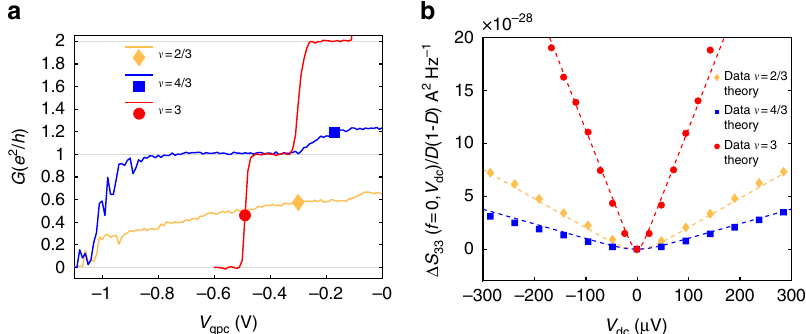
Fig. 2 Low frequency measurements. a Conductance through the QPC as a function of the QPC gate voltage for the three fi lling factors ν = 3 (red), ν = 4/3 (blue) and ν = 2/3 (yellow). The values of the QPC gate voltage used for noise measurements are shown by a colored disk ( ν = 3), square ( ν = 4/3) and diamond ( ν = 2/3). b Measurements of Δ S 33 ( f = 0, V dc ) normalized by the factor D (1 − D ). Dashed lines represent plots of Eq. (1) using q = e , g ¼ e 2 ν = 3, q = e /3, g ¼ e 2 at ν = 4/3 and q = e /3, g ¼ 2 e 2 at ν = 3 h 3 h